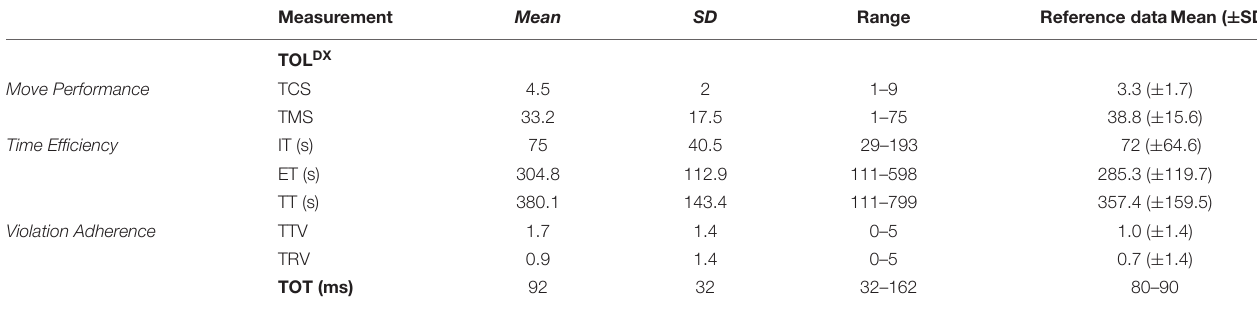
TABLE 3 | Descriptive statistics of results obtained in TOL DX and TOJ tasks.